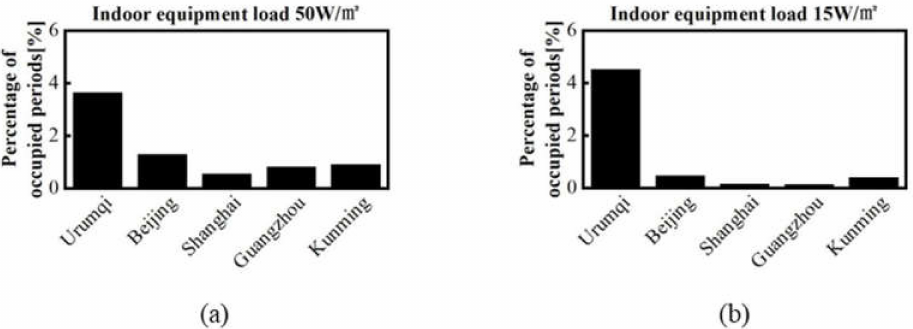
Figure 6. Percentage of annual discomfort hours according to the rule-based control strategy during occupied hours in different climate zones with different indoor equipment load: ( a ) indoor equipment load of 50 W/m 2 ; ( b ) indoor equipment load of 15 W/m 2